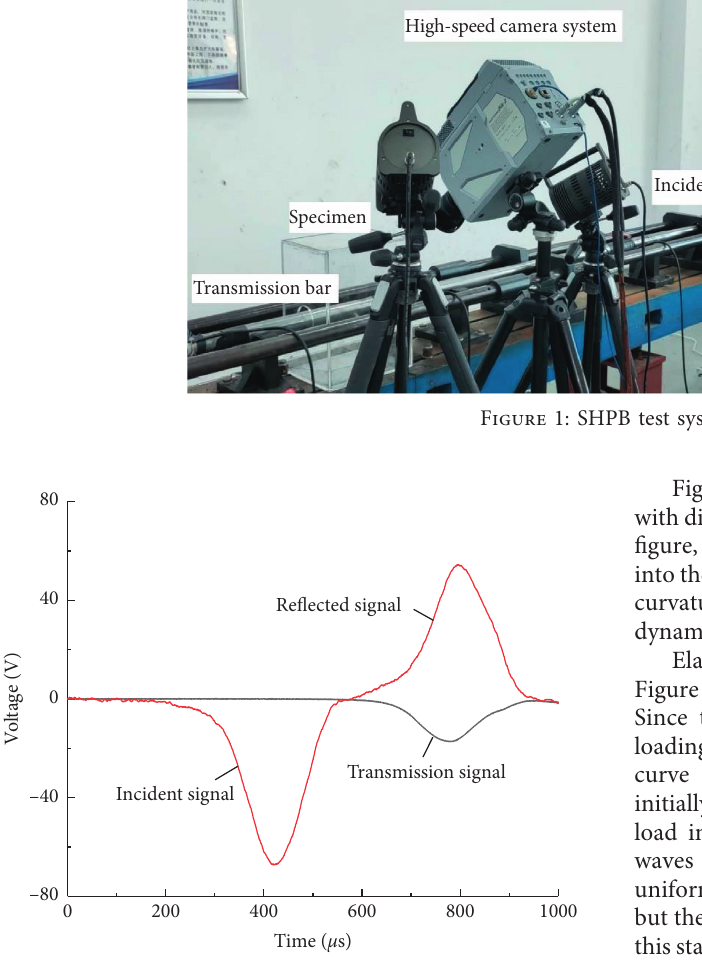
Figure 2: Classical waveform diagram of the coal SHPB